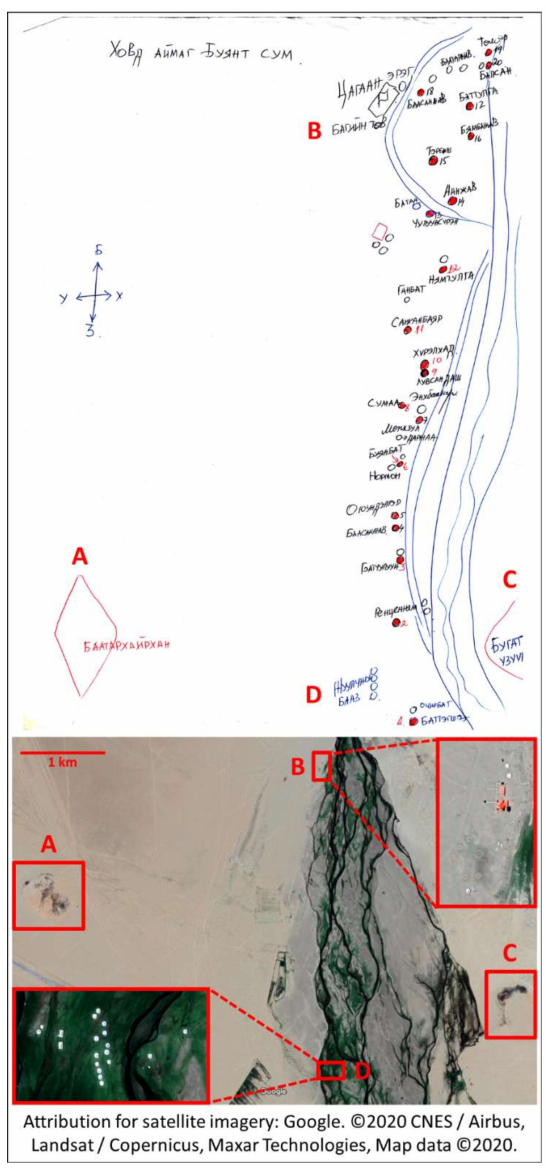
Figure 1. A health o ffi cer’s map of rural participant locations juxtaposed with satellite imagery. In rural areas, local health department sta ff are skilled at locating and tracking surrounding nomadic families, despite their frequent movements. This is exemplified by this map, quickly drafted from memory for the study team’s use by a local health o ffi ce working in the rural Buyant subdistrict of Khovd province (western Mongolia). The following landmarks can be found in the map and the satellite map of the same study site: A : “Baatarkhairkhan” mountain; B : local administration center, C : “Deer antler”